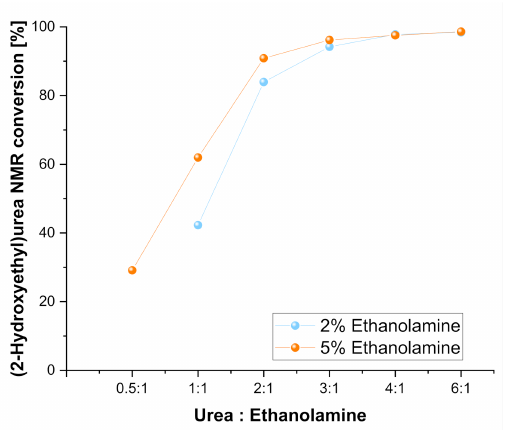
Figure 5. Formation of (2-hydroxyethyl)urea as a function of urea/ethanolamine ratio from 0.5:1 to 6:1. The reactions were carried out with 2% and 5% v/v concentrations of ethanolamine in H 2 O/D 2 O (product composition determined after 48 h at 80 ◦